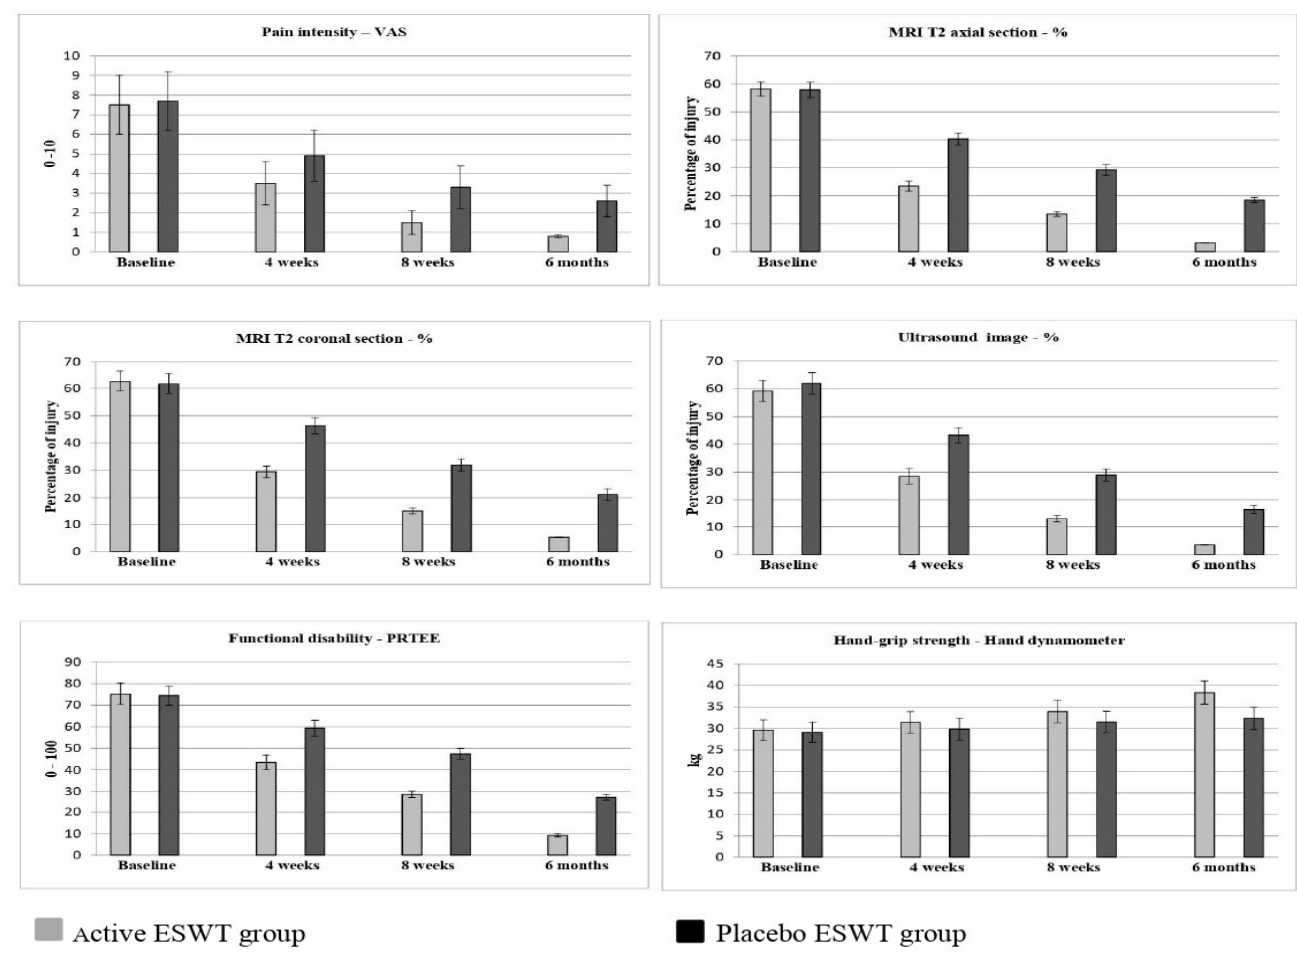
Figure 2. Pre- and post outcome measures of active and placebo ESWT groups.